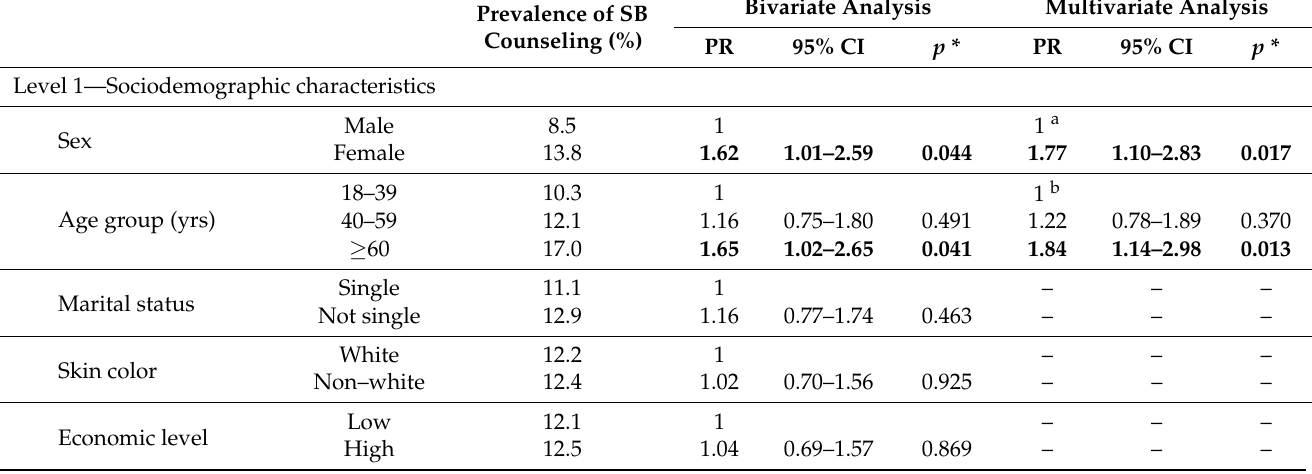
Table 4. Associated factors with sedentary behavior (SB) counseling received from healthcare